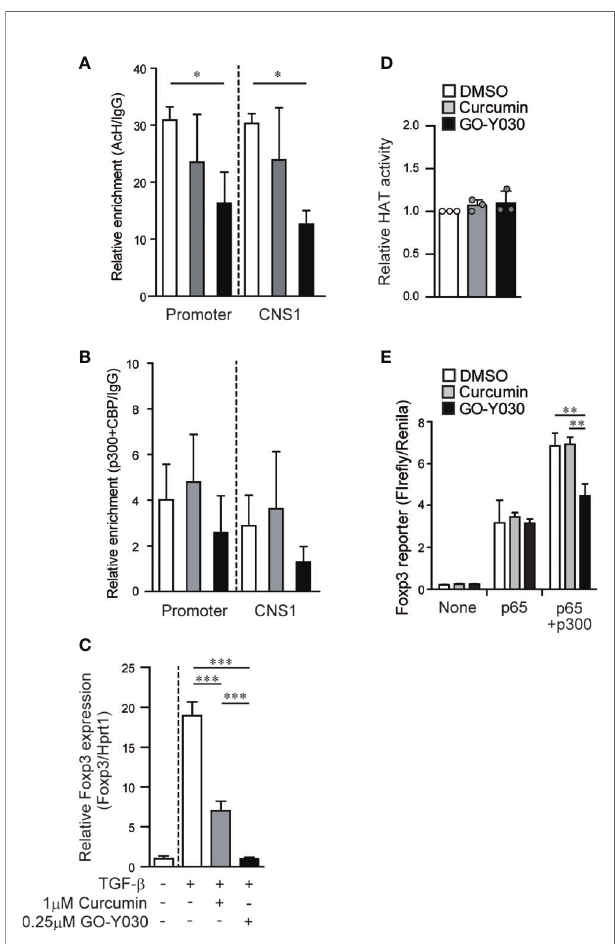
FIGURE 2 | GO-Y030 reduces the level of histone acetylation at the Foxp3 locus and prevents Foxp3 gene expression. (A, B) Real-time PCR documenting the relative amount of chromatin immunoprecipitation [acetyl histone H3K27/IgG (A) and acetyl transferase p300+CBP/IgG (B) ] at the Foxp3 locus (n = 3) using cultured naïve CD4+ T cells (24 h) in the presence of 2 ng/ml TGF- b with or without curcumin, GO-Y030, and DMSO. White